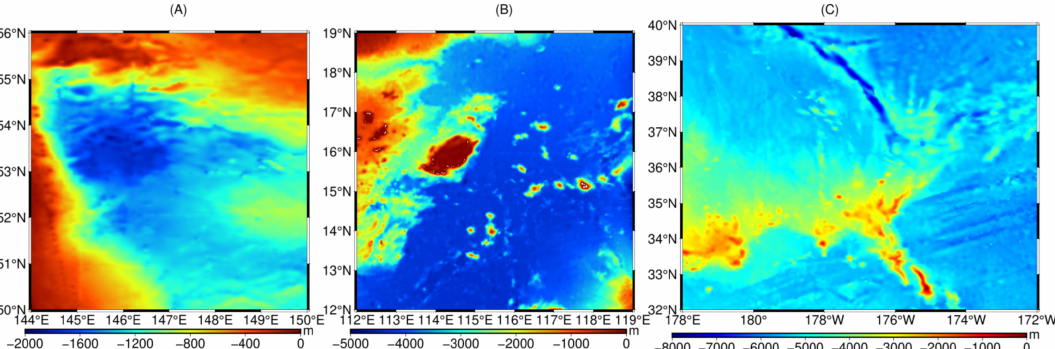
Figure 13. Submarine Topographic Map of the Study Area: ( A ) the study region with water depth ranging between 0~2000 m; ( B ) the study region with water depth ranging between 0~5000 m; ( C ) the study region with water depth ranging between 0~8000